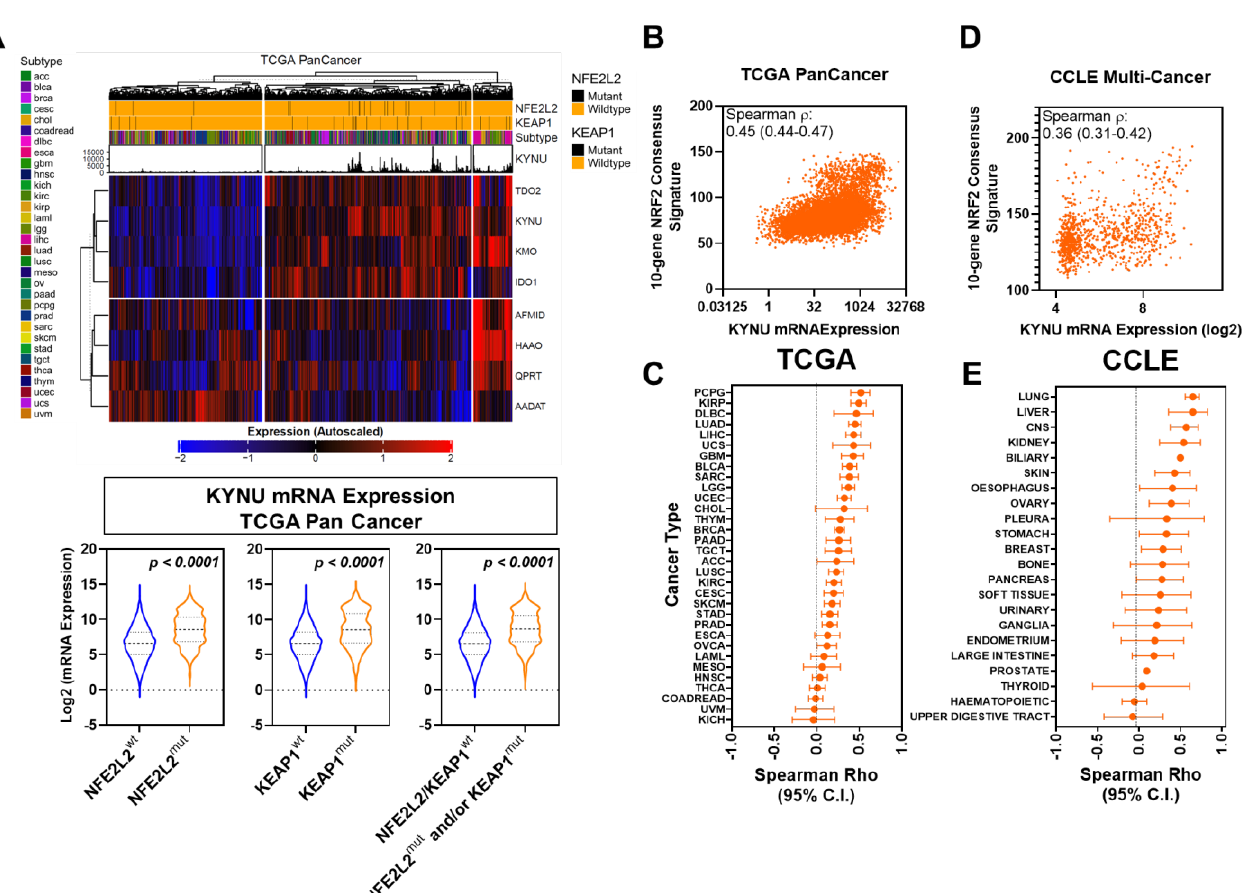
Figure 1. Association between KYNU gene expression and NRF2 status across different cancer types. ( A ) Unsupervised heatmap showing gene expression of kynurenine pathway (KP) enzymes and their association with NFE2L2 and KEAP1 mutational status across 9801 tumors representing 32 cancer types in the TCGA transcriptomic datasets. Violin plots illustrate the mRNA levels of KYNU among tumors stratified based on mutations in NRF2 (NFE2L2) and/or KEAP1 . Statistical significance was determined by the 2-sided Wilcoxon rank sum test. ( B ) Scatter plot depicting the association between KYNU mRNA levels and a 10-gene NRF2 signature [3] across the 9803 tumors from TCGA. ( C ) Dot plot showing Spearman rho correlation coefficients (95% confidence interval) between tumoral KYNU mRNA levels and the 11-gene NRF2 signature across the 32 cancer types in the TCGA PanCancer Atlas dataset. ( D ) Scatter plot illustrating the relationship between KYNU mRNA levels and the 11-gene NRF2 signature [3] across the 1037 cancer cell lines from CCLE. ( E ) Dot plot depicting Spearman rho correlation coefficients (95% confidence interval) between KYNU mRNA levels and the 11-gene NRF2 signature across cancer cell lines stratified into 22 anatomical sites in CCLE.